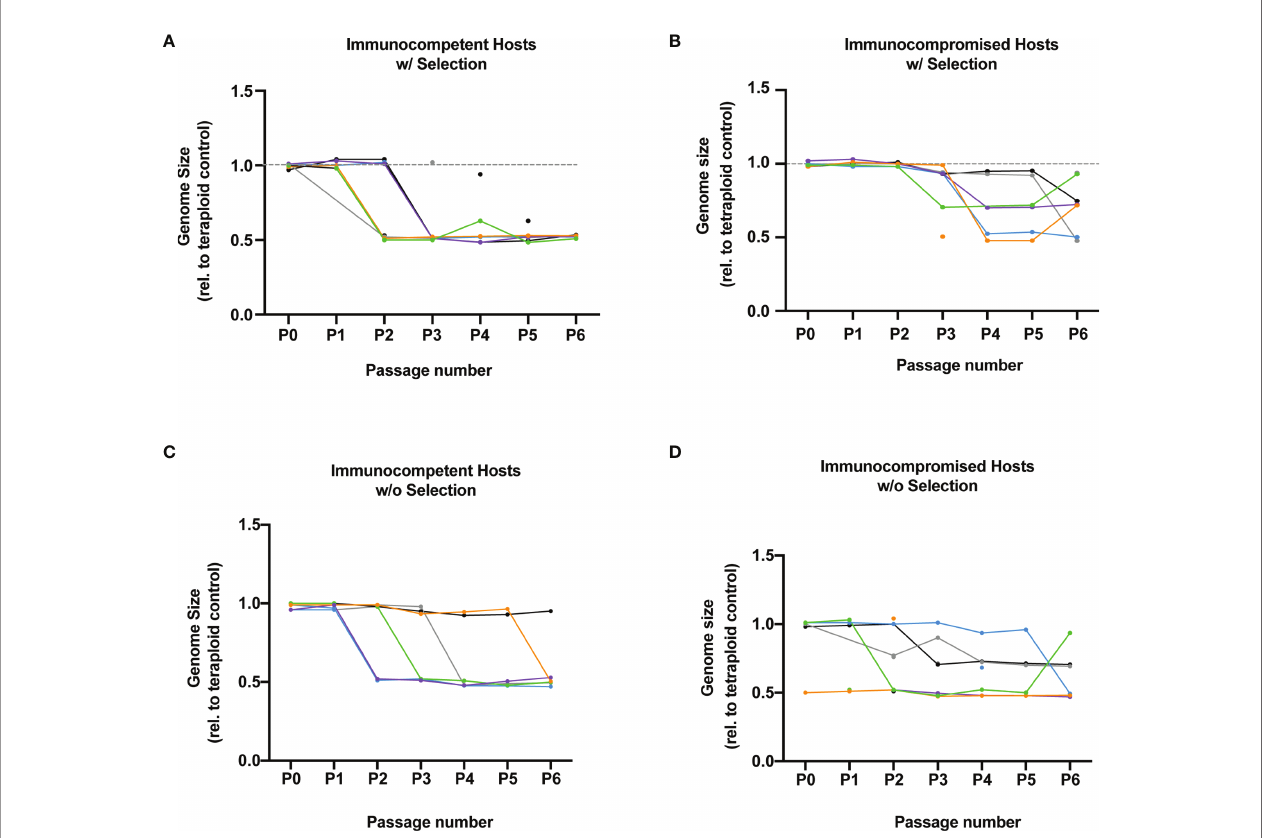
FIGURE 2 | Tetraploids genome size change trajectories following evolution (A) Plotted is the genome size of C. albicans relative to a tetraploid control following passaging in immunocompetent hosts with selection for six passages. Each different colored line represents 1 of the 6 unique lineages. Multiple points indicate cell populations with multiple ploidies. (B) Same as (A) but for immunocompromised hosts under selective pressure (C) Same as (A) but for immunocompetent hosts not under selection (D) Same as (A) but for immunocompromised hosts not under